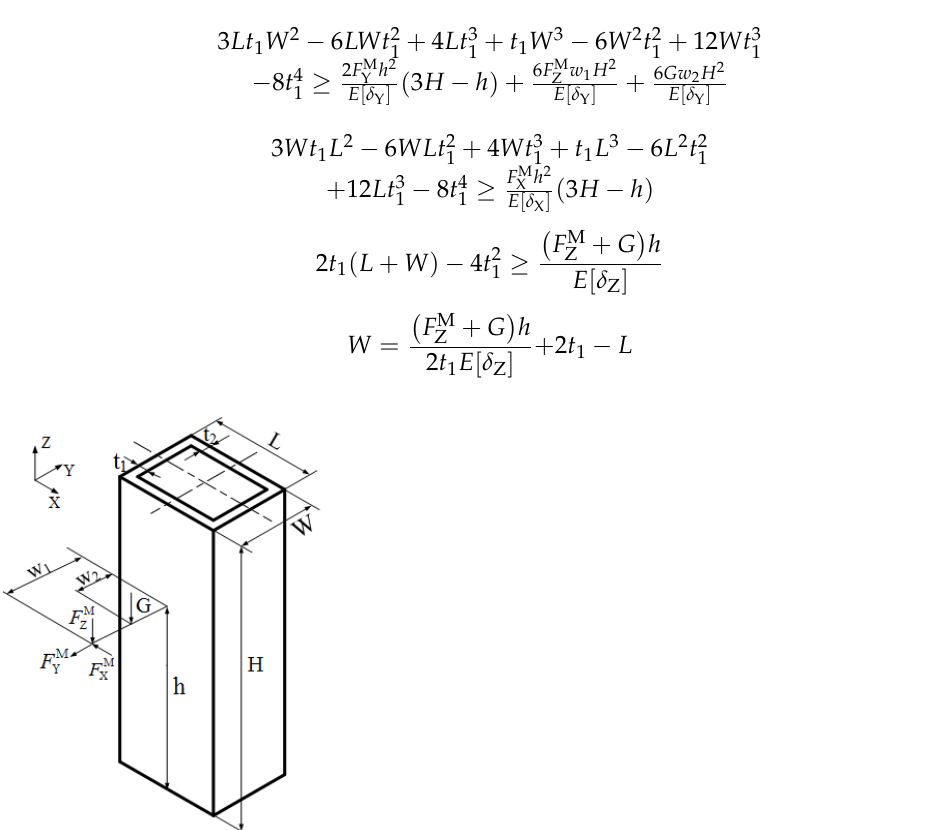
Figure 2. The structure scheme of the micro-machine tool.